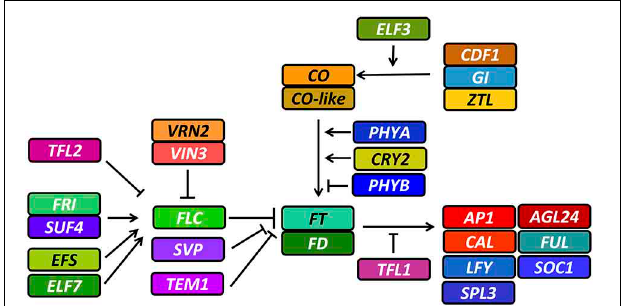
FIGURE 1 | Overview of relevant flowering time genes and their interactions in A. thaliana . Full gene names and descriptions of their interactions are given in the text. Arrows indicate positive regulation, whereas blunt ends indicate